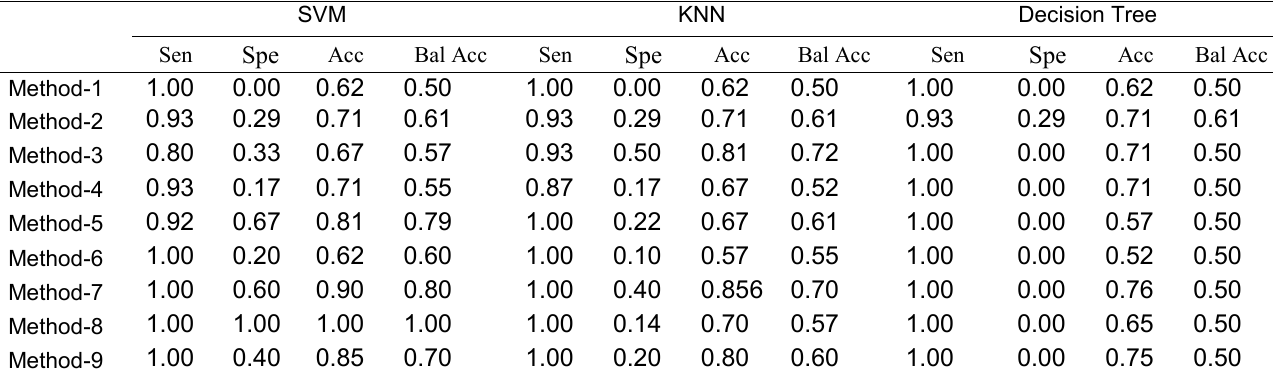
Table 9. Performance of classifiers for pelvis